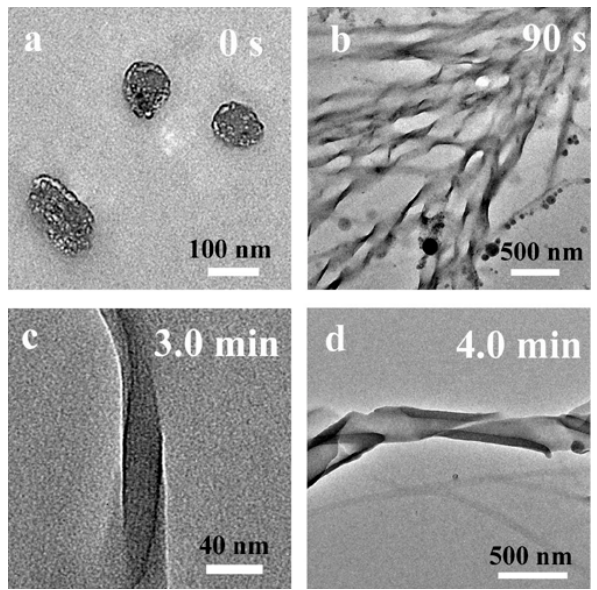
Figure 5. TEM images of the reaction mixture after ( a ) 0 s; ( b ) 90 s; ( c ) 3.0 min; and ( d ) 4.0 min. Reproduced with permission from [52]. Copyright 2008 Royal Society of Chemistry.